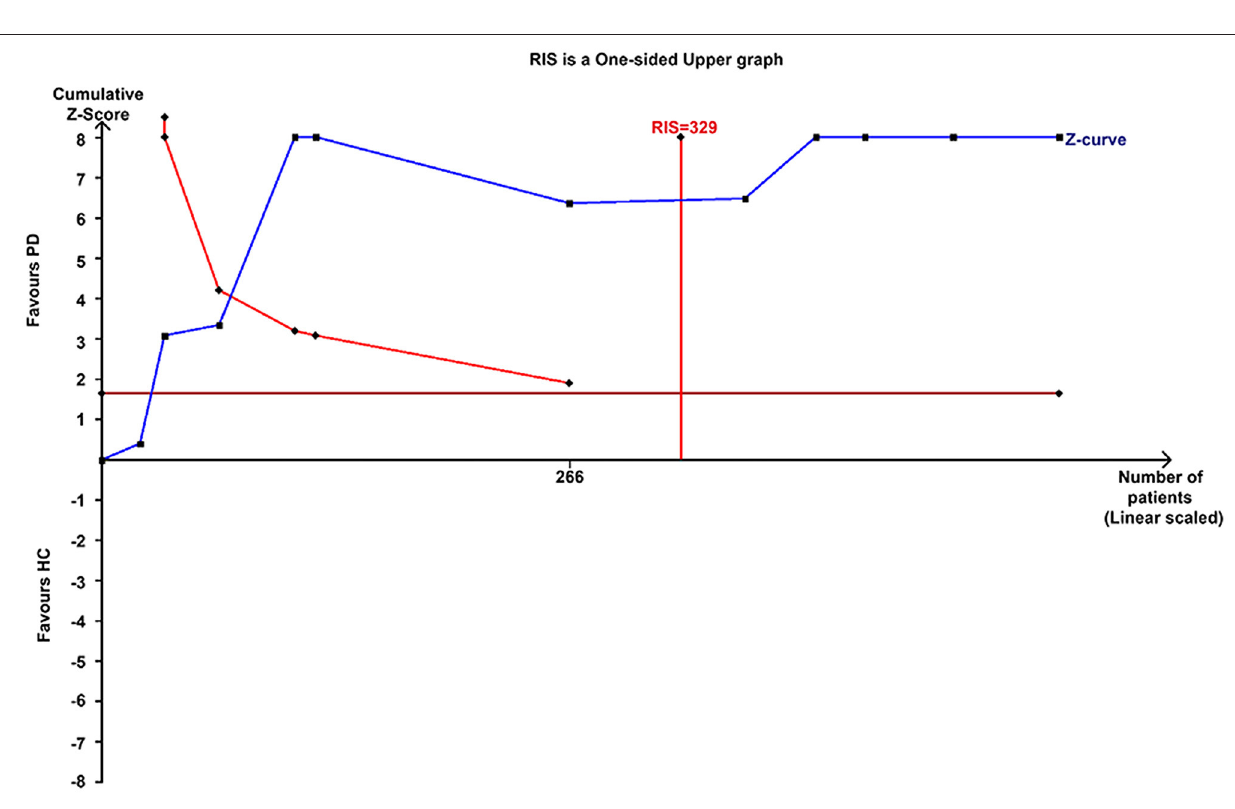
Frontiers in Neurology |